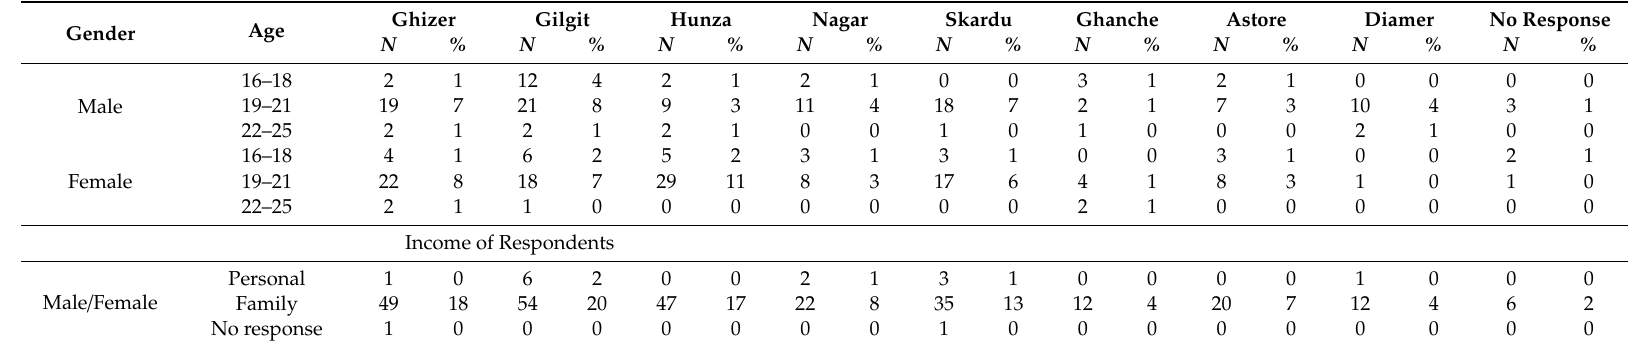
Table 1. Participants characteristics (respondents age, gender, and income).